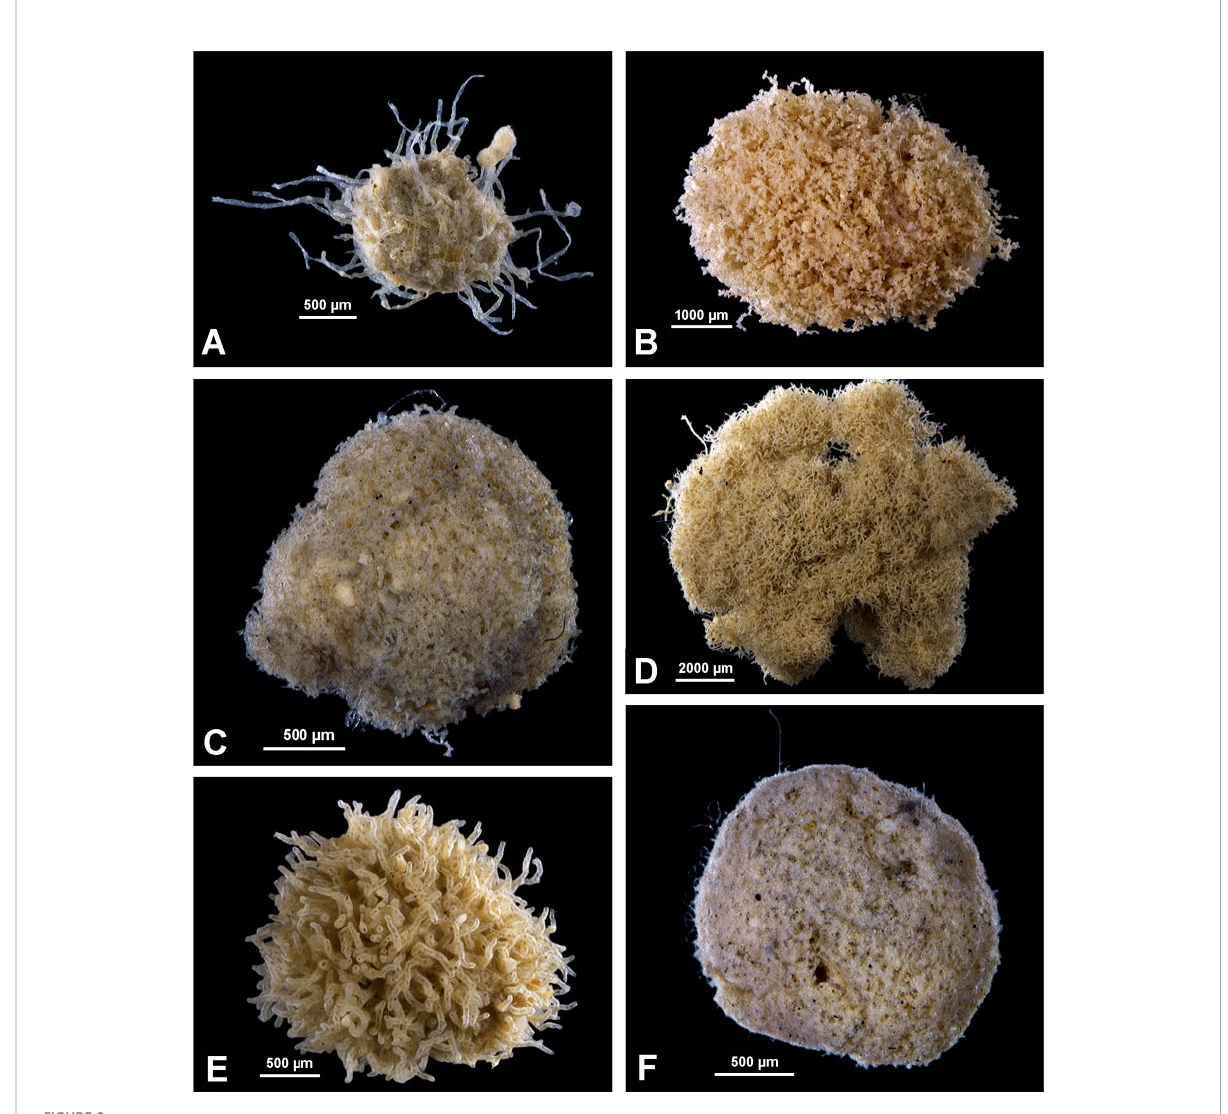
FIGURE 2 Komoki. (A) Edgertonia argillispherula Tendal & Hessler, 1977; Belgium area, sample 118. (B) Edgertonia tolerans Tendal & Hessler, 1977; IOM area, sample 99. (C) Reticulum conical; Belgium area, sample 118. (D) Reticulum pad-like; IOM area, sample 99. (E) Septuma brachyramosa Kamenskaya, 1993; Belgium area, sample 118. (F) Mudball with dotted surface; German area, sample